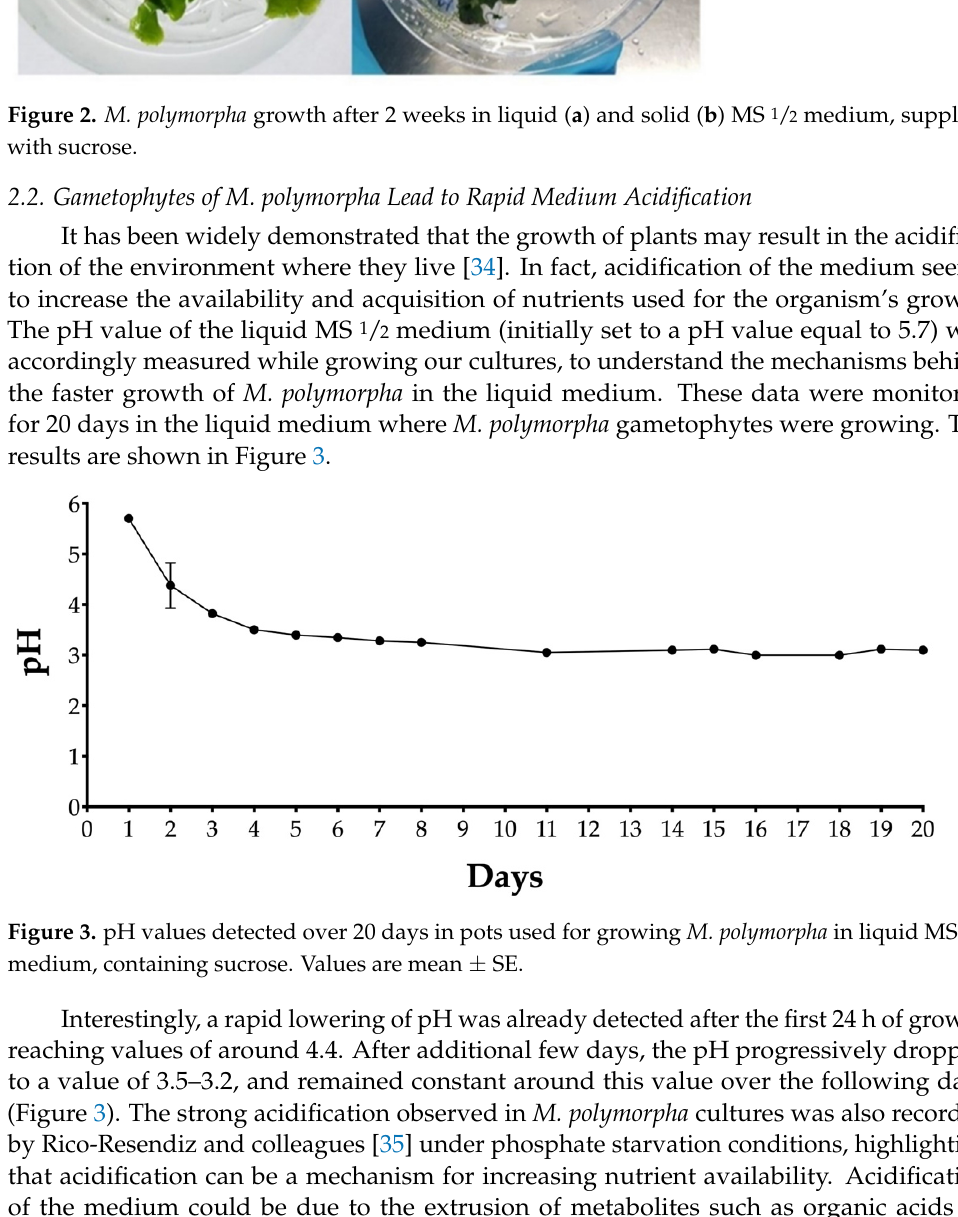
Figure 2. M. polymorpha growth after 2 weeks in liquid ( a ) and solid ( b ) MS ½ medium, supplied with sucrose.